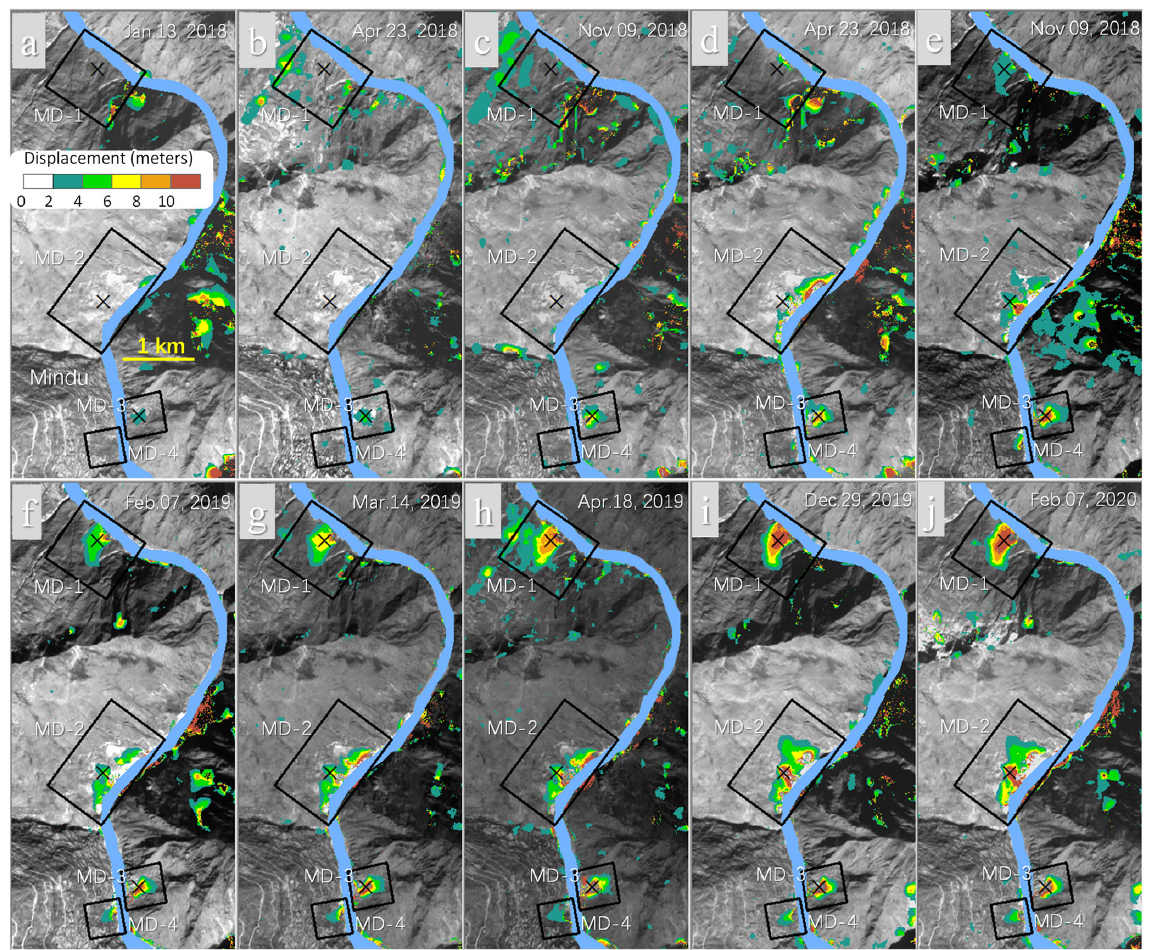
Figure 4. Cumulative hillslope displacements near Mindu village at different times between early 2018 and early 2020 using the early 2017 image (either January or February) as the reference. Cumulative displacement (a, b) before the first Baige flood, (c) between the two floods, and (d–j) at different times between 29 November 2019 and 7 February 2020. Background images are respective target Sentinel-2 images of the end date for the calculation.